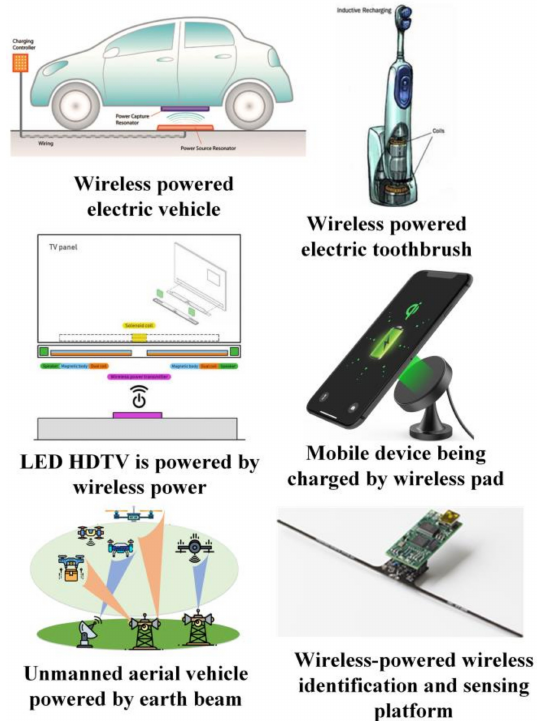
Figure 2. Applications of WPT technologies in WPSNs